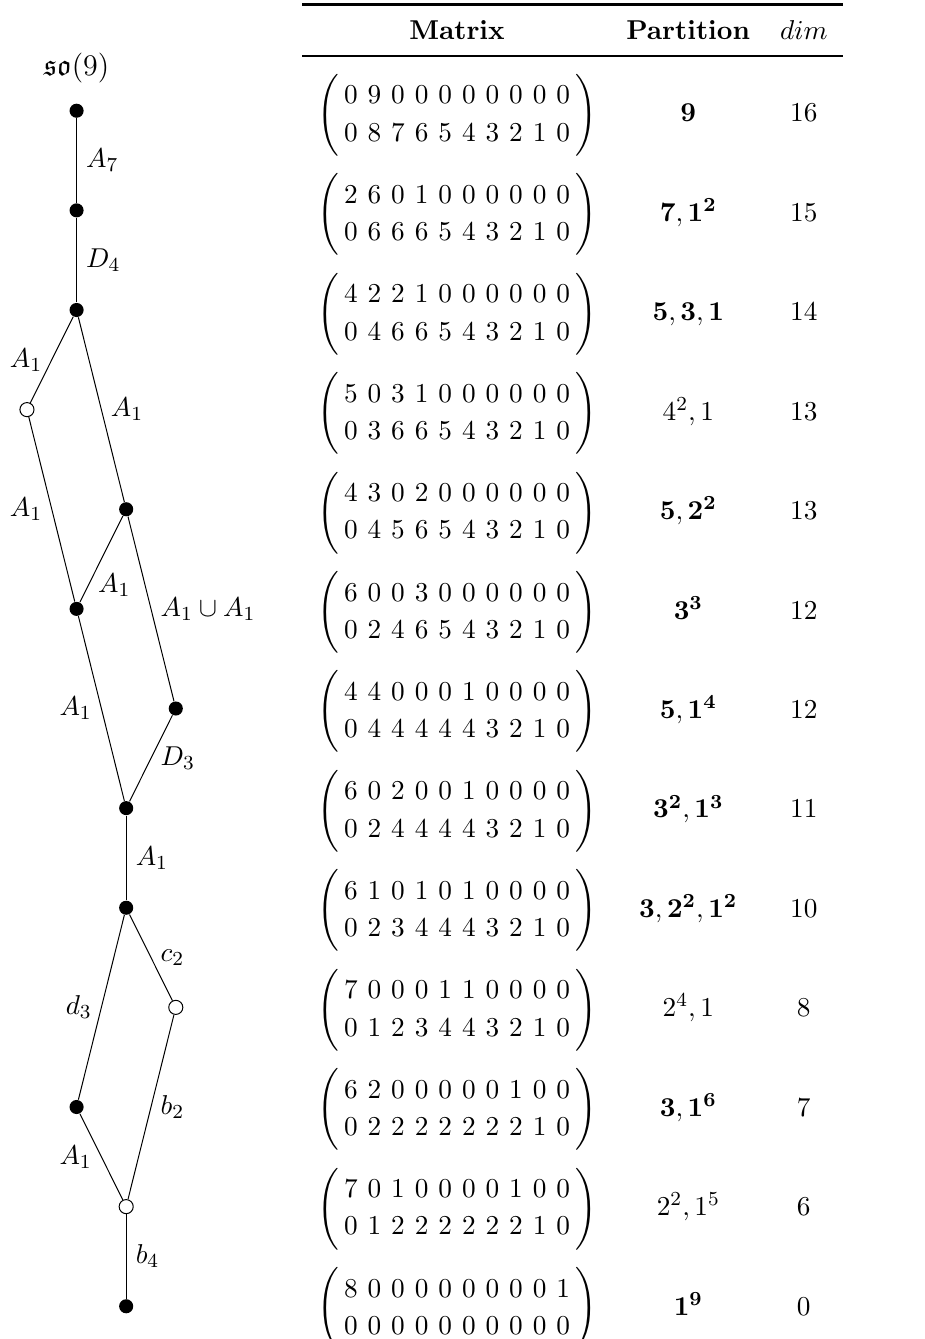
Table 16. Results obtained applying the matrix formalism to so (9).